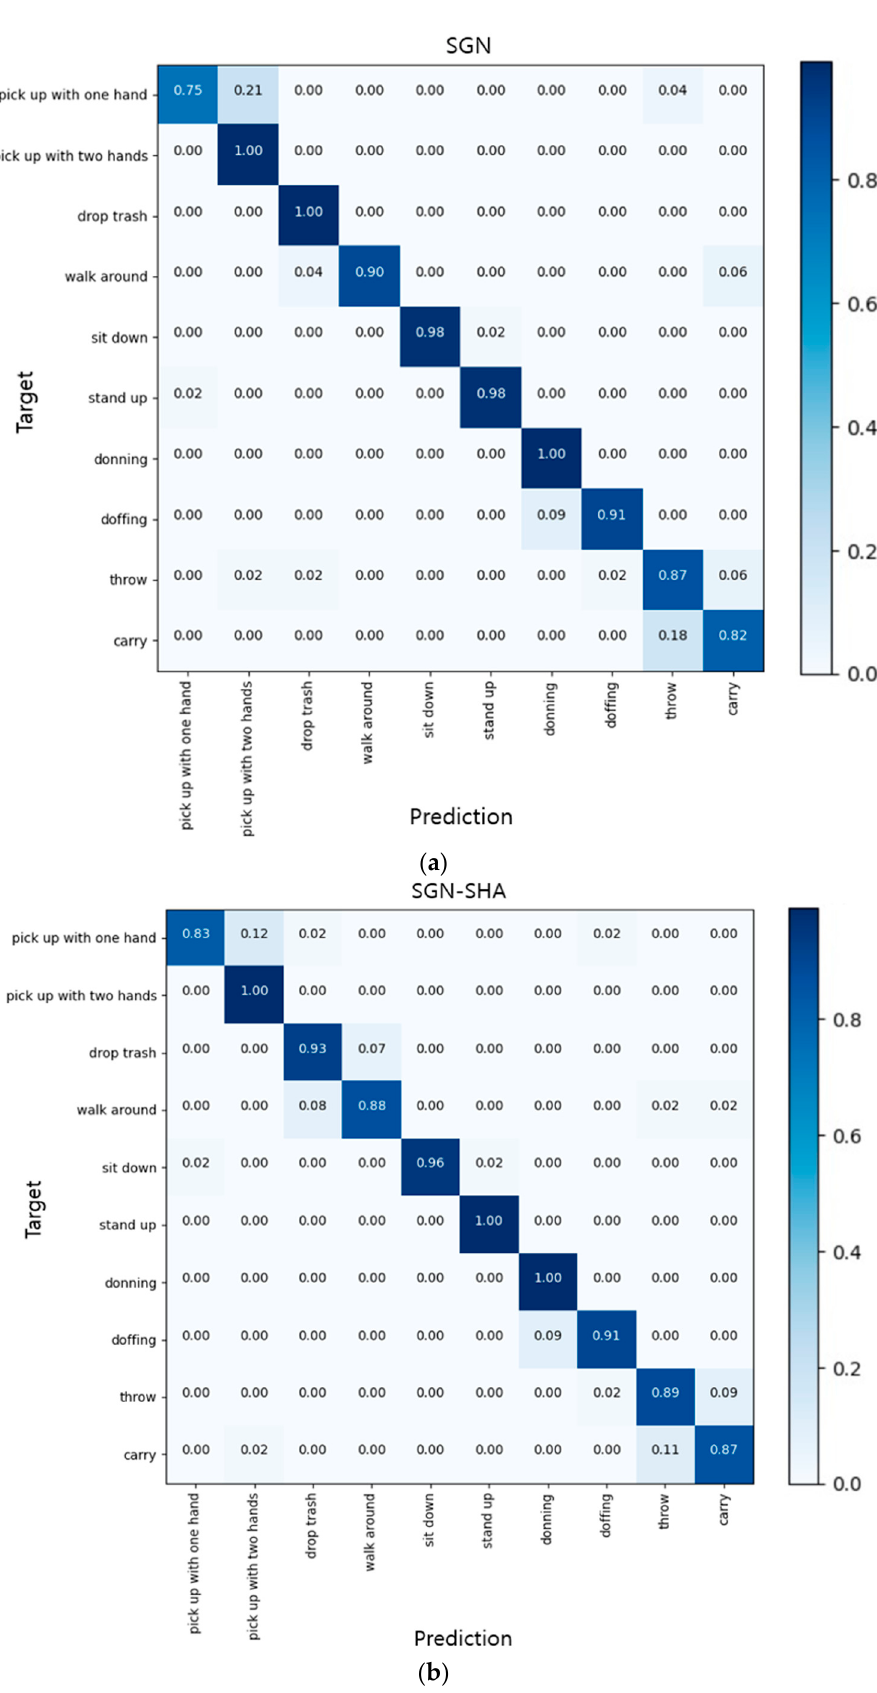
Figure 3. Comparison of confusion matrix accuracy of ( a ) SGN and ( b ) SGN-SHA for detailed actions in NW-UCLA dataset.